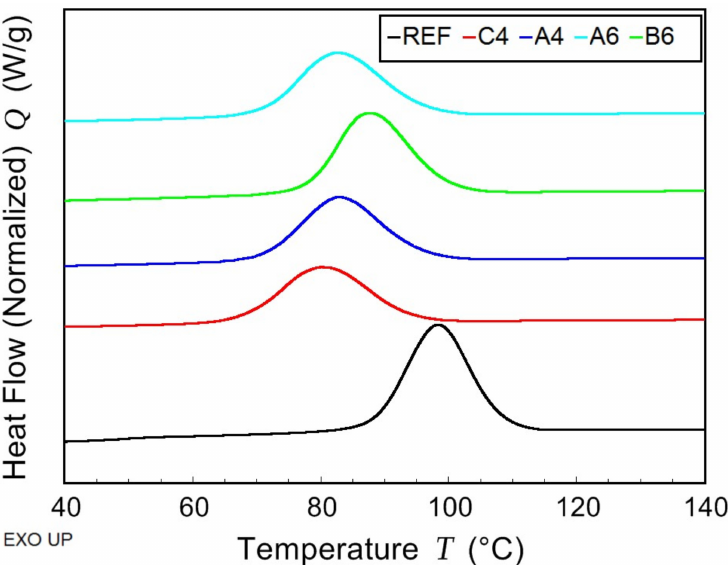
Figure 4. Differential scanning calorimetry (DSC)—first cooling scan of non-plasticized reference sample (REF) and PHB/PLA/Plasticizer (where the plasticizers are: C-4, A-4, B-6, and